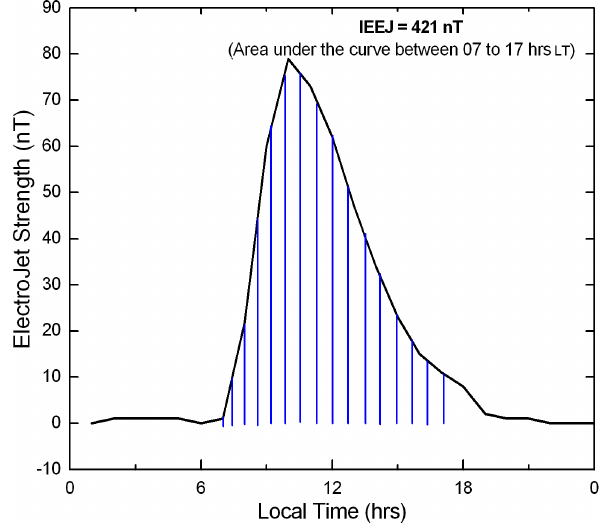
Fig. 2. Method of computing the Integrated Equatorial ElectroJet (IEEJ) strength. The area under the curve measured at each hour between 07:00 and 17:00 LT is taken as IEEJ strength.